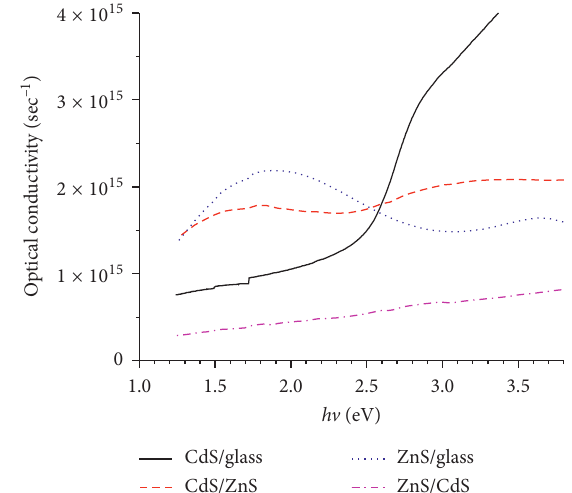
Figure 5: Plots of optical conductivity ( σ ) versus photon energy ( hv ) for CdS/glass, CdS/ZnS, ZnS/glass, and ZnS/CdS thin